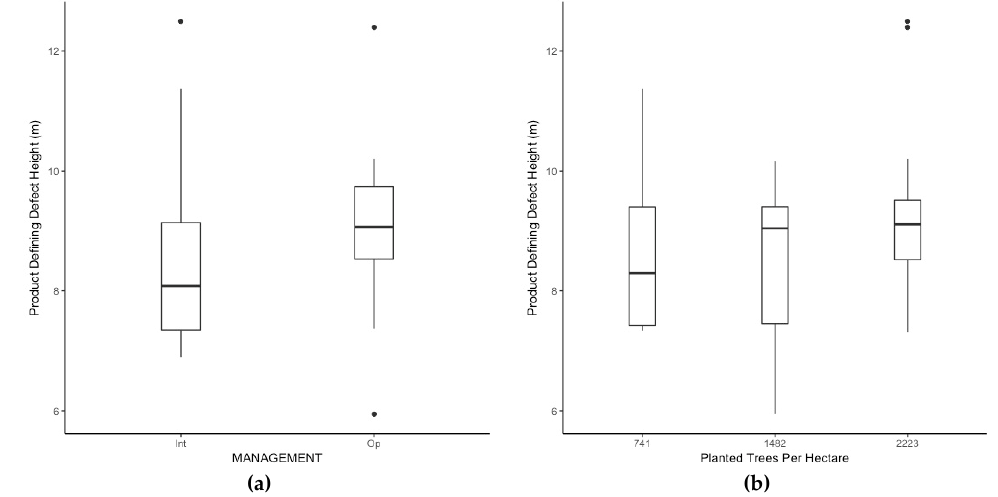
Figure 4. Product-defining defect height by management intensity ( a ) and planting density ( b ) across six installations of PMRC SAGS Culture × Density non-thinned sites (Int = intensive, Op. = operational). Outliers are displayed with a solid dot.